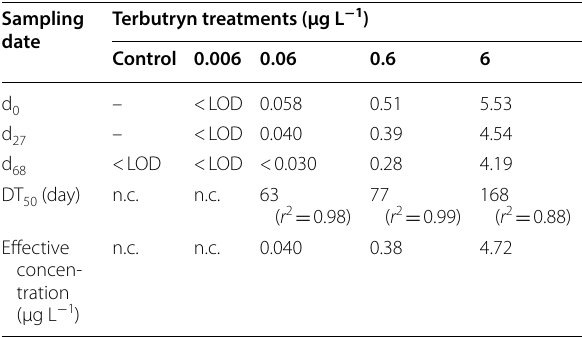
Table 2 Analysed terbutryn concentrations in the water phase at d d and d in the different treatments 0, 27, 68 under consideration of the SPE recovery rate of 87.2%